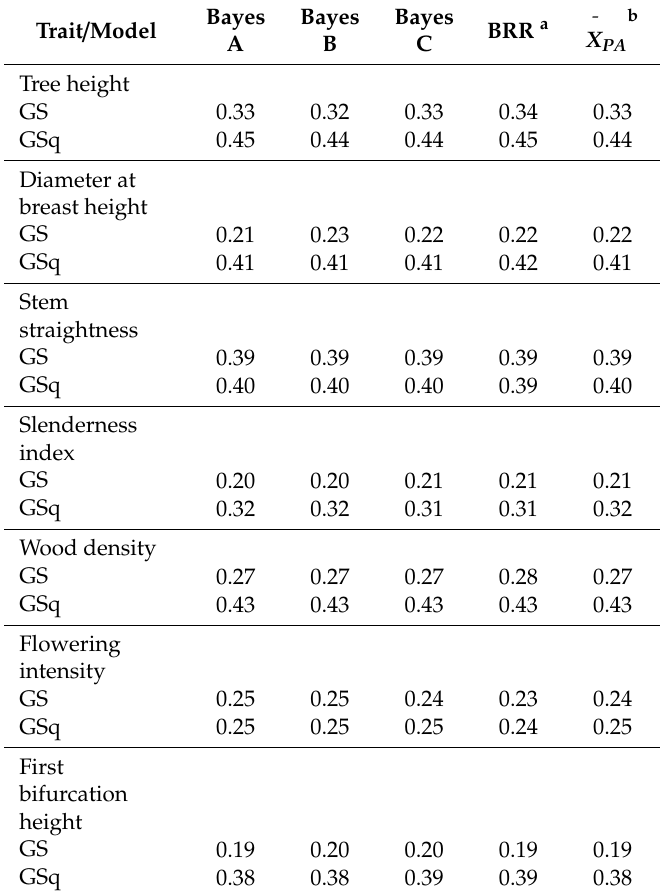
Table 2. Predictive ability (PA) of all studied traits in Eucalyptus cladocalyx according to (i) polygenic background (pedigree information) and all informative markers (GS model) and (ii) polygenic background, QTL-genotype e ff ects (determined by GWAS) and SNP markers that were not associated with any trait (GSq model). The PA values for each method correspond to the mean of PA values for 20-folds of